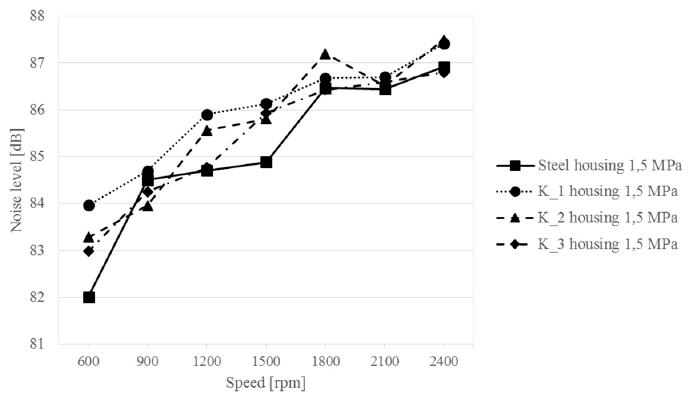
Figure 9. Changes in the sound level above the upper gearbox plate at different rotational speeds of the gear—1.5 MPa load.